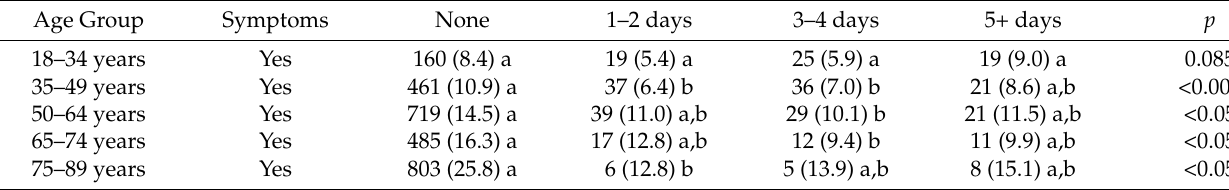
Table S1 shows the binary multiple logistic regression model, explaining 9.1% of the variance (Nagelkerke’s R 2 ) of the depression symptoms variable. Table S2 shows the binary multiple logistic regression model, explaining 8.5% of the variance (Nagelkerke’s R 2 ) of